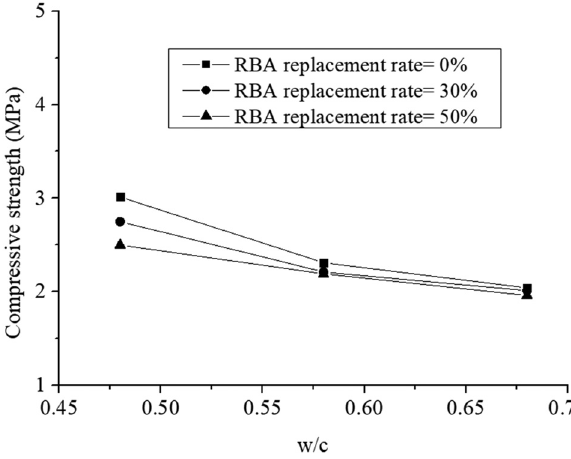
Figure 8: Splitting tensile strength versus